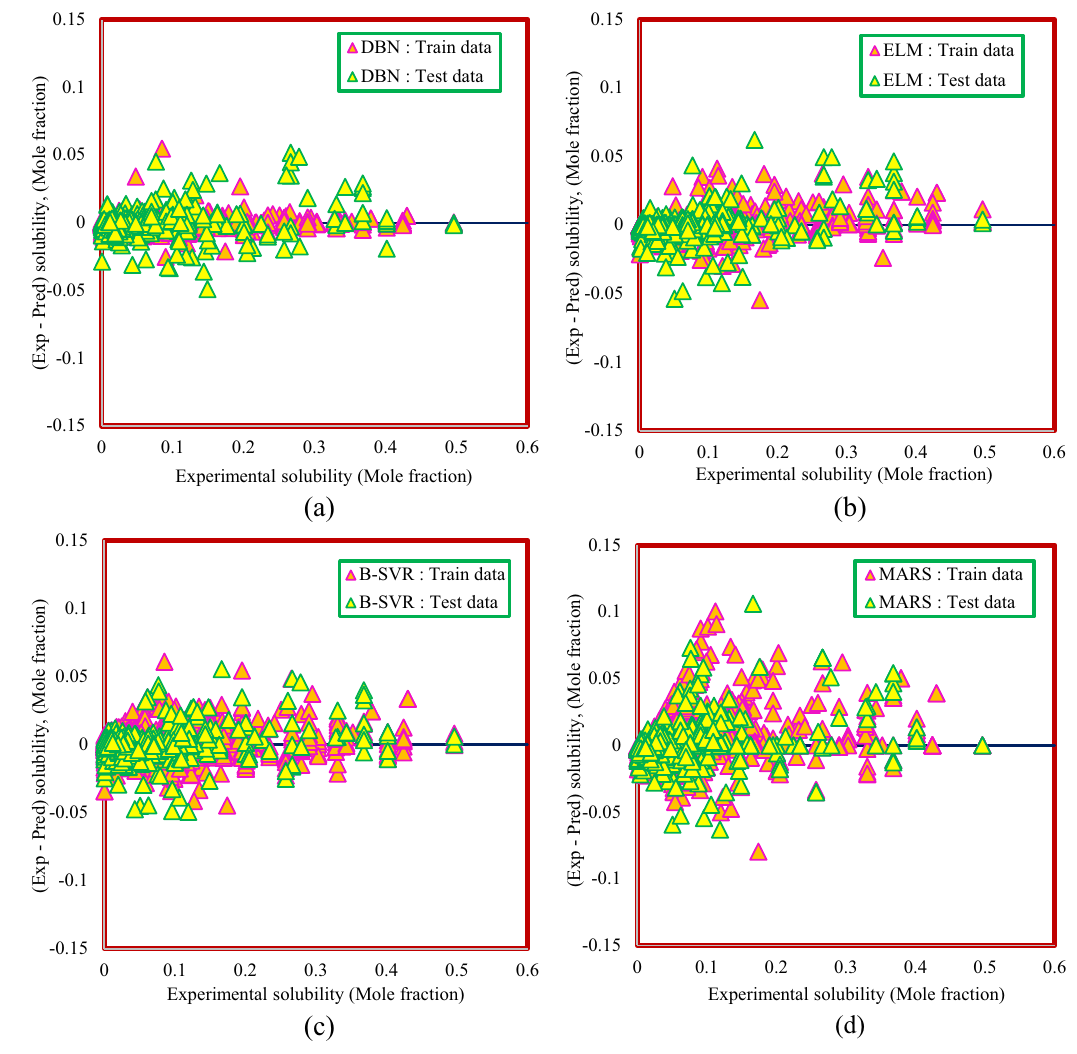
Figure 10. Distribution of deviation of predicted values from actual values for Model (I): ( a ) DBN model, ( b ) ELM model, ( c ) B-SVR model, ( d ) MARS